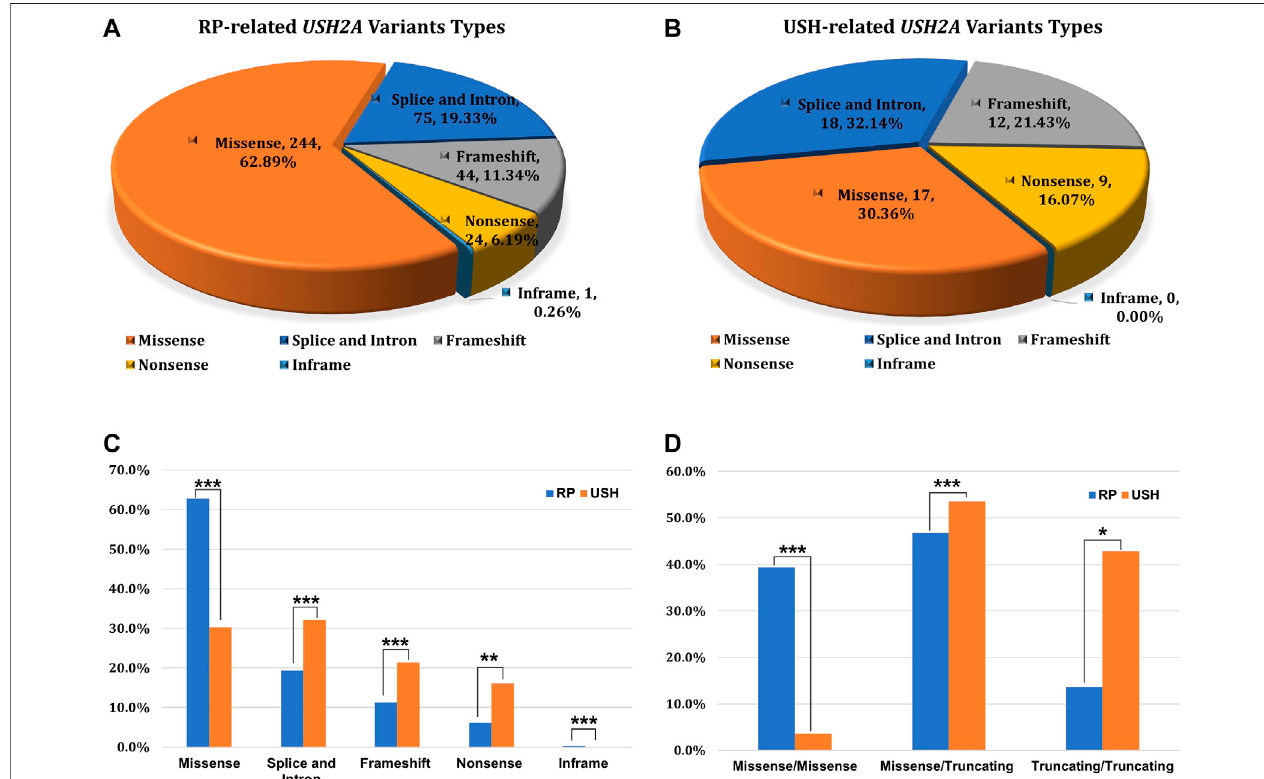
FIGURE3| Thetypeofvariationandthedistributionofgenotypesubgroups. (A) Variationtypesof388allelesinUSH2A-relatedRPpatients( n =190); (B) Variation types of56alleles inUSH2A-related USH patients( n =28); (C) Alleleratios ofdistinctvariant types betweenRPand USH, missensegroup (244 vs. 17), splice and intron group(75vs.18),frameshiftgroup(44vs.12),nonsensegroup(24vs.9),inframegroup(1vs.0); (D) ComparisonofvariantcombinationsbetweenRPandUSHpatients, missense/missense group(75 vs.1), missense/truncatinggroup(89 vs.15), andtruncating/truncatinggroup(26vs. 12). χ 2 test: * p < 0.05;** p < 0.01;*** p <